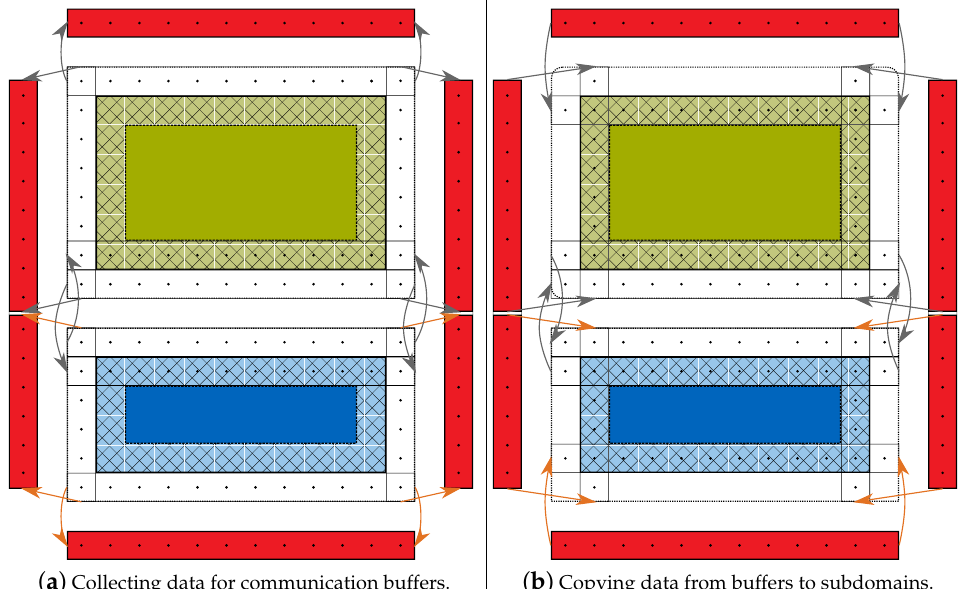
Figure 6. β -step collection ( a ) and distribution ( b ) of data. The behavior of one MPI process with four communication partners is illustrated in 2D. For color coding and meaning of data transfer arrows, see Figure 5. Lattice cells affected by read/write operations are marked with a